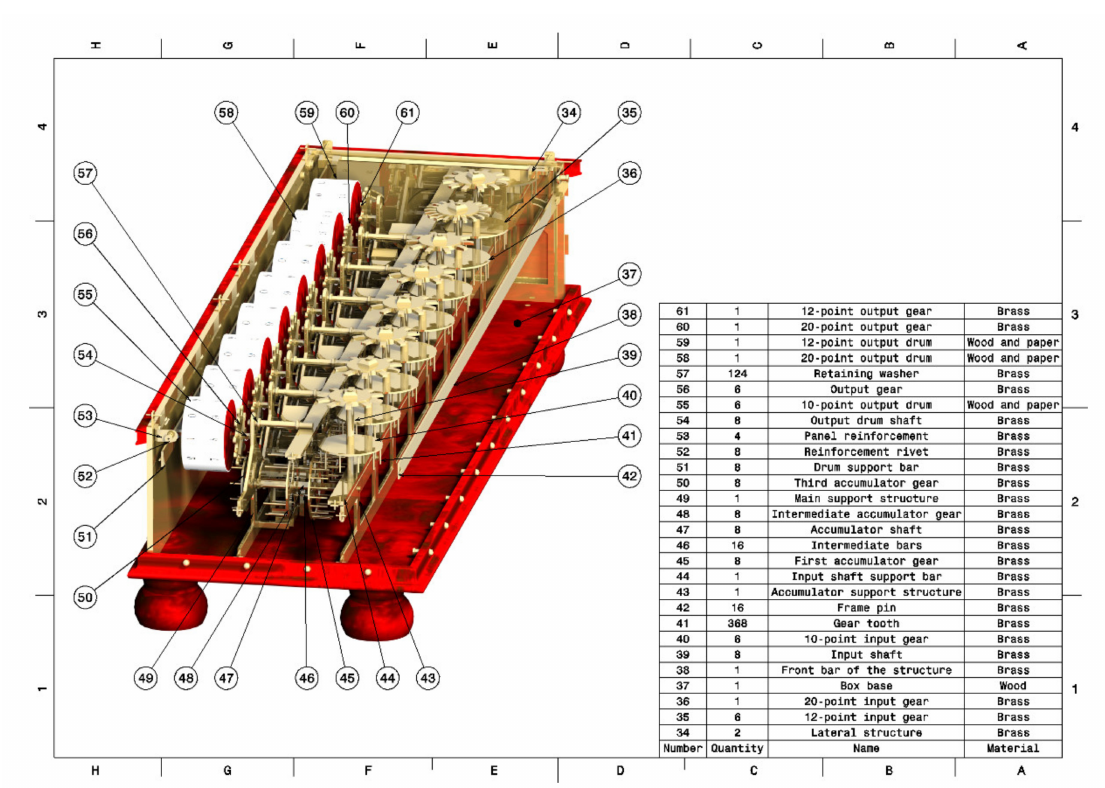
Figure 3. Assembly plan of the interior of the Pascaline using transparencies of the lid, and side and front panels (Elements